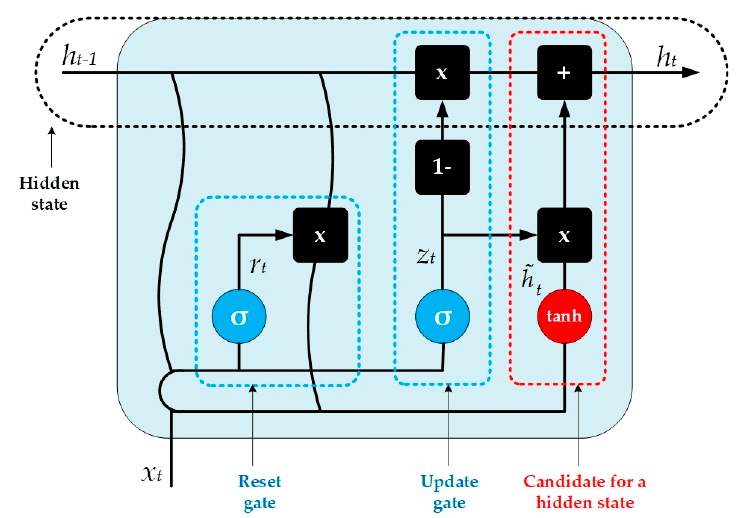
Figure 3. The GRU unit structure. Figure 2. The GRU unit structure.